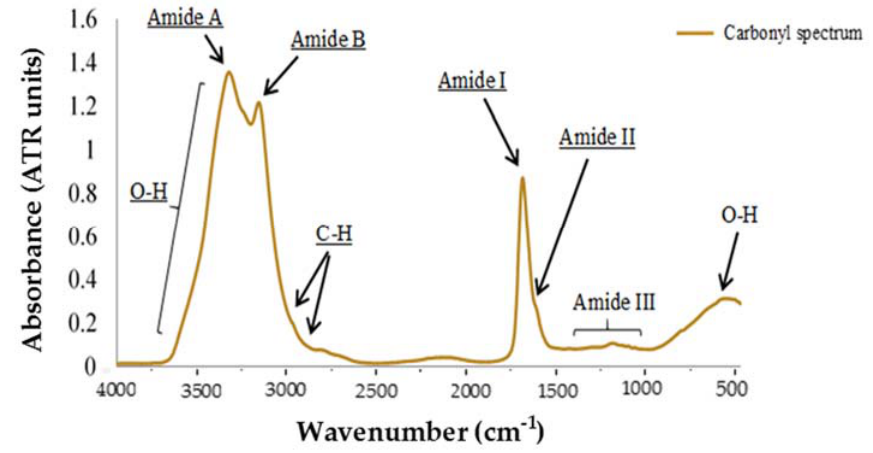
Figure 5. Results of MIR absorbance spectra from P_OX (protein oxidation) compounds.